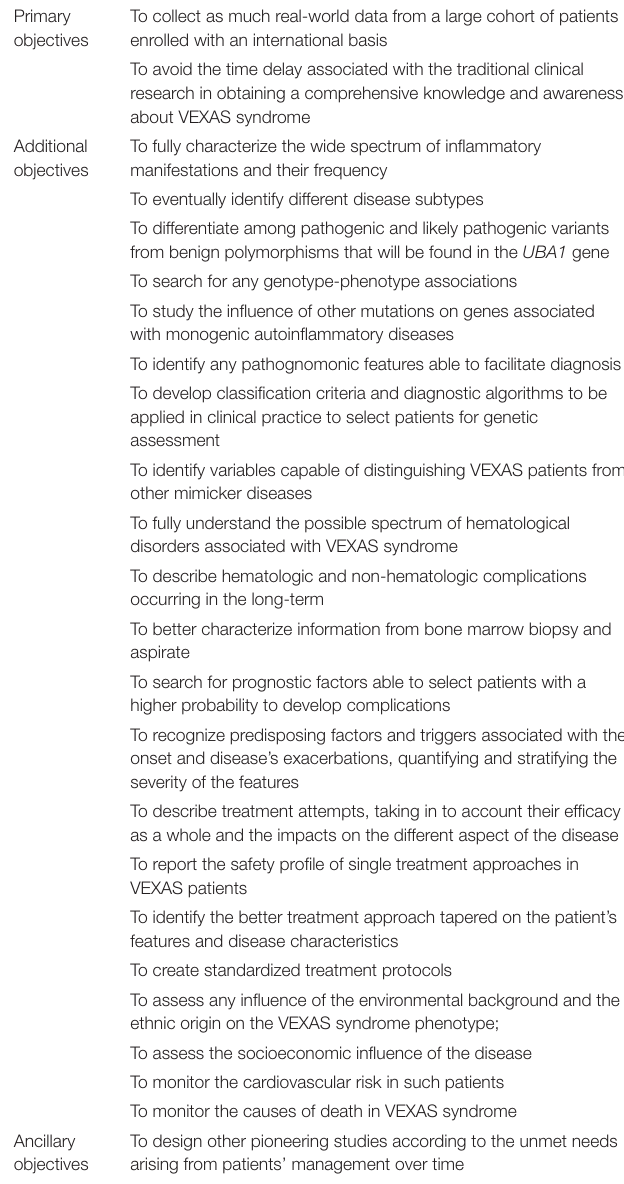
TABLE 1 | Objectives considered for the implementation of the AIDA registry for patients with VEXAS (vacuoles, E1 enzyme, X-linked, autoinflammatory, somatic)